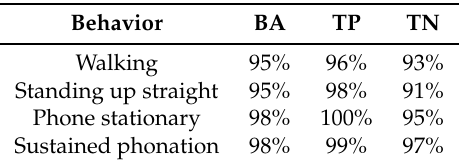
Table 1. Balanced accuracy (BA), true positive (TP) and true negative (TN) rates for the nonparametric switching AR model trained on walking and balance tests performed in a controlled environment. The TP rate reflects the ability to correctly identify an activity when occurring, and the TN rate reflects the ability to correctly indicate the lack of that activity whenever it is not